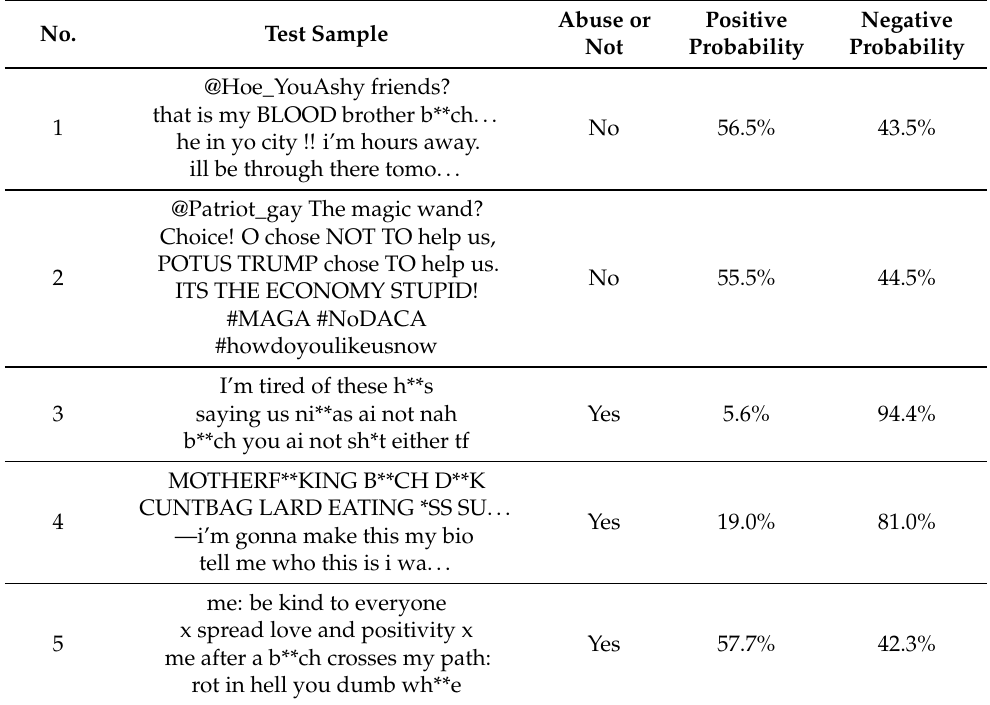
Table 5. Case study. Some test samples which contain abuse language leading to a neutral emotion (samples 1 and 2). Most abuse language tends to show strong negative emotions (samples 3 and 4). In rare cases, the emotion labeling is unreliable (sample